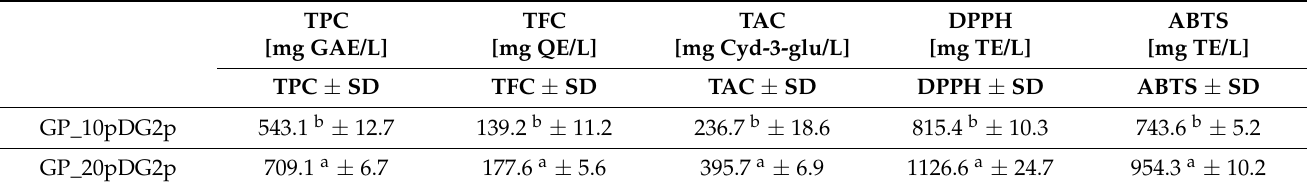
Table 3. Antioxidant capacity (DPPH, ABTS), total phenolic (TPC), flavonoid (TFC), and anthocyanin (TAC) content in grape